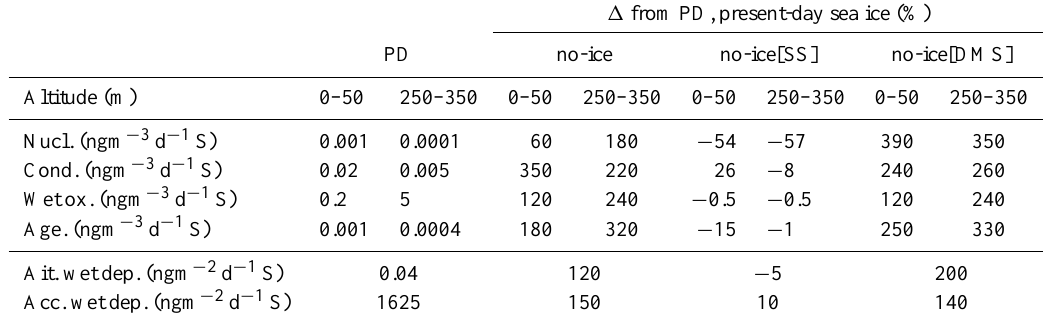
Table 2. Change in nucleation (Nucl.), condensation (Cond.), aqueous phase oxidation (Wet ox.), ageing (Age), accumulation mode scaveng- ing (Acc. wet dep.) and Aitken mode scavenging (Ait. wet dep.) flux between the present day and our ice-loss scenarios (no-ice, no-ice[SS] and no-ice[DMS]). We also show the present-day absolute value of each metric (column 1). Our average flux is calculated over grid boxes where the CCN response to sea-ice loss is less than − 10% (Fig. 5). Note: the same grid boxes are used to derive an average flux in all runs. Thus, the response of modelled microphysical processes from the no-ice[SS] and no-ice[DMS] runs does not necessarily reflect a CCN response of less than −